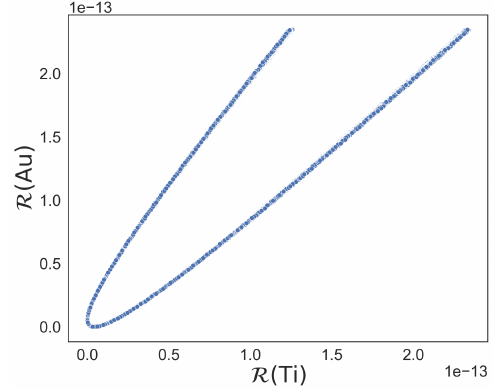
Figure 6 . Scatter plot Br( Z → ¯ µe ) vs. Br( µ → ee ¯ e ) .